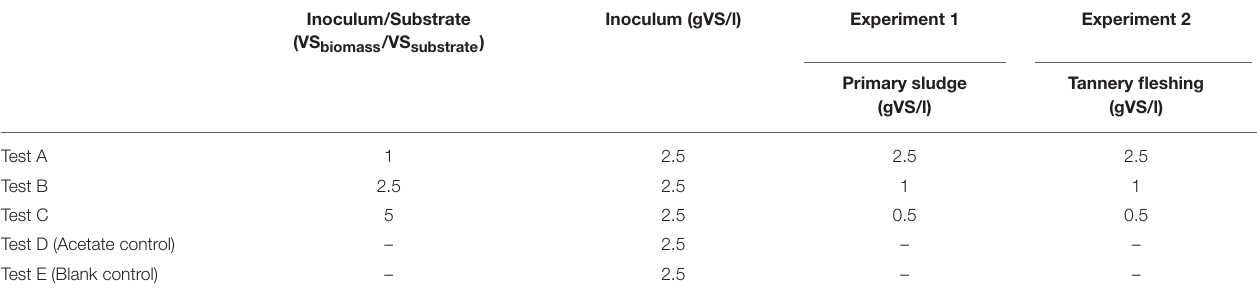
TABLE 1 | Experimental Inoculum/Substrate initial